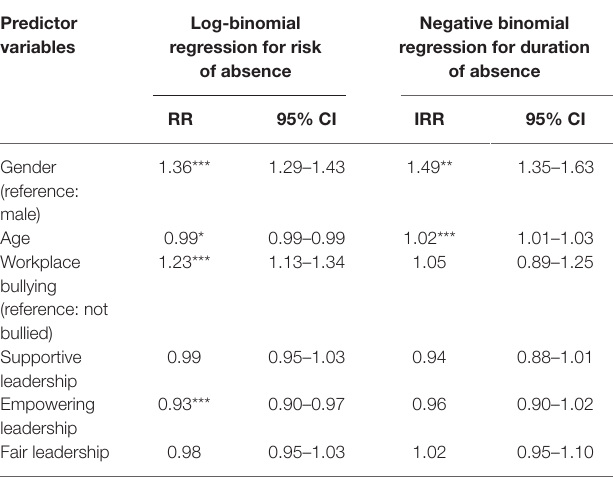
TABLE 1 | Hurdle analysis of associations between workplace bullying and different forms of leadership as predictor variables and medically certified sickness absence as outcome variable, adjusted for age and gender ( N = 10,691).